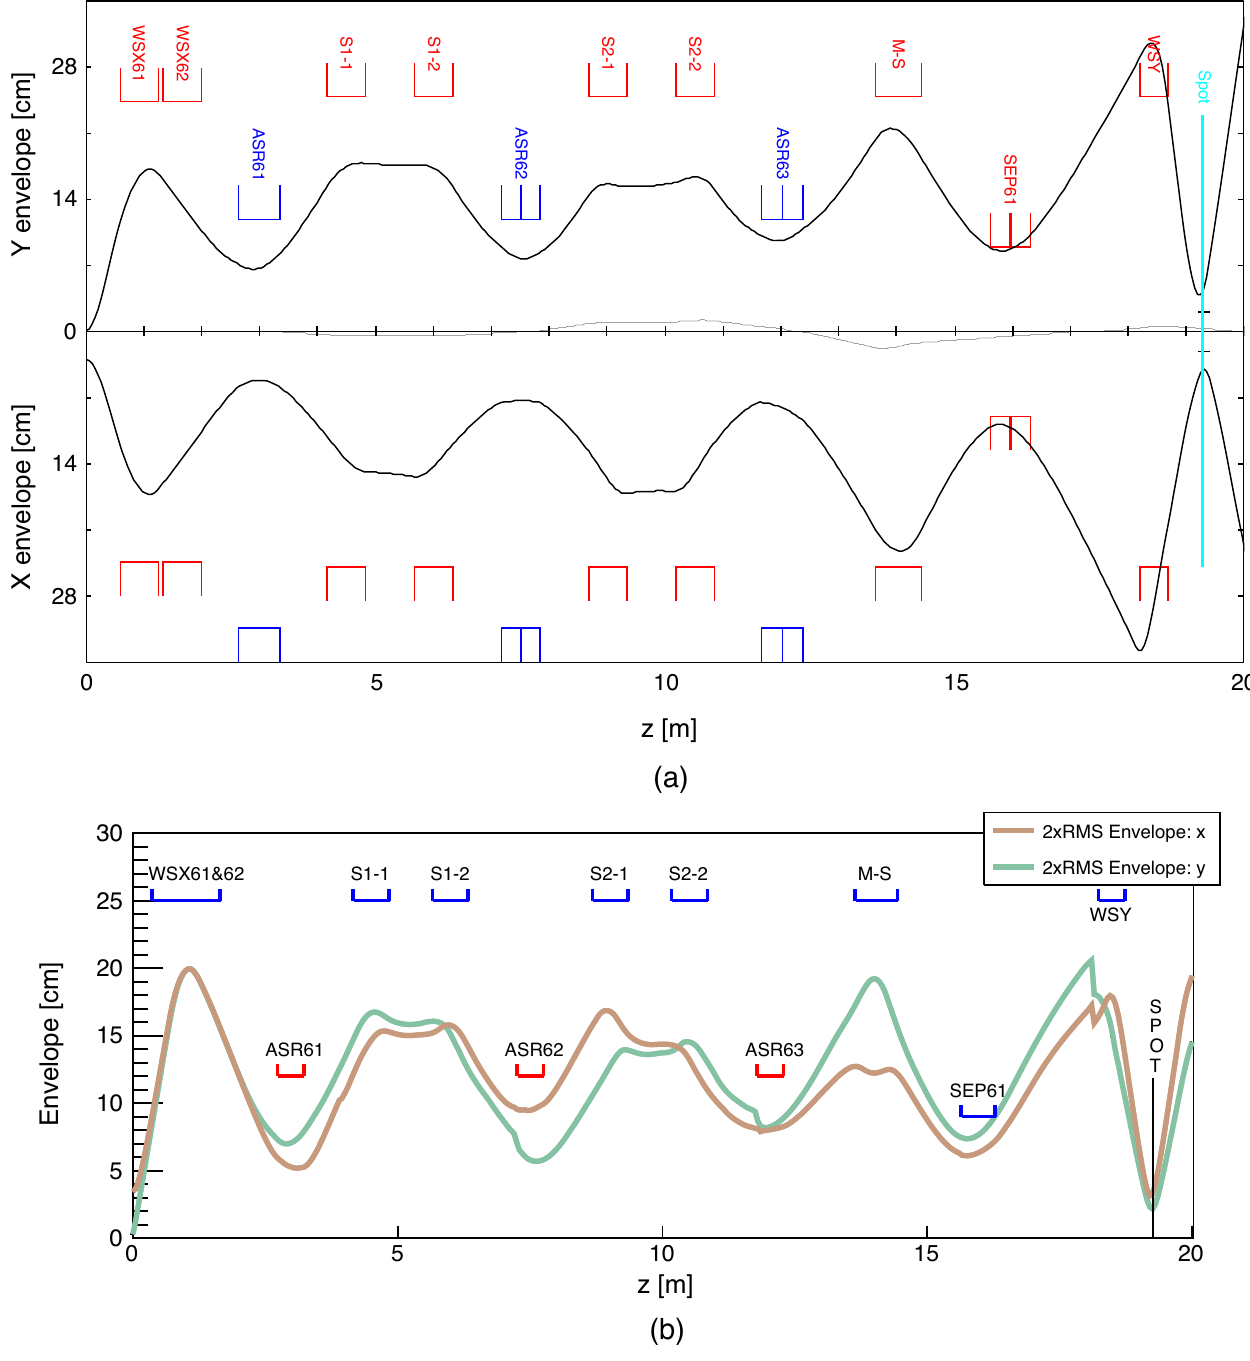
FIG. 23. (a) Second-order optical calculation for the Super- μ E 4 in TRANSPORT . Initial parameters used in TRANSPORT are (half-width): x ¼ 30 mm, x 0 ¼ 200 mrad, y ¼ 2 . 5 mm, y 0 ¼ 200 mrad, dp=p ¼ 4 . 5% . (b) Beam envelopes ( 2 × rms) in multiparticle simulation after optimizing the magnetic fields using a homogeneous beam distribution at the source. Initial beam parameters as in